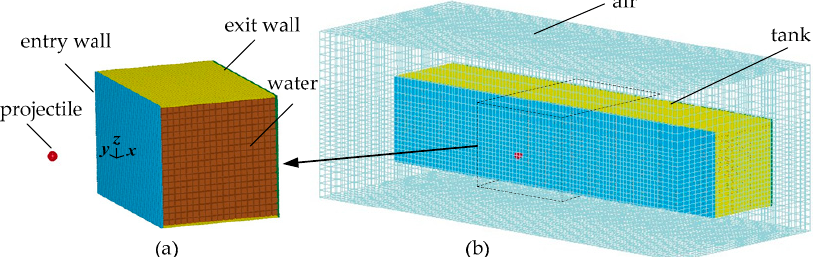
Figure 2. ( a ) Local magnification diagram of the simulation model. ( b ) The simulation model of the Varas test.